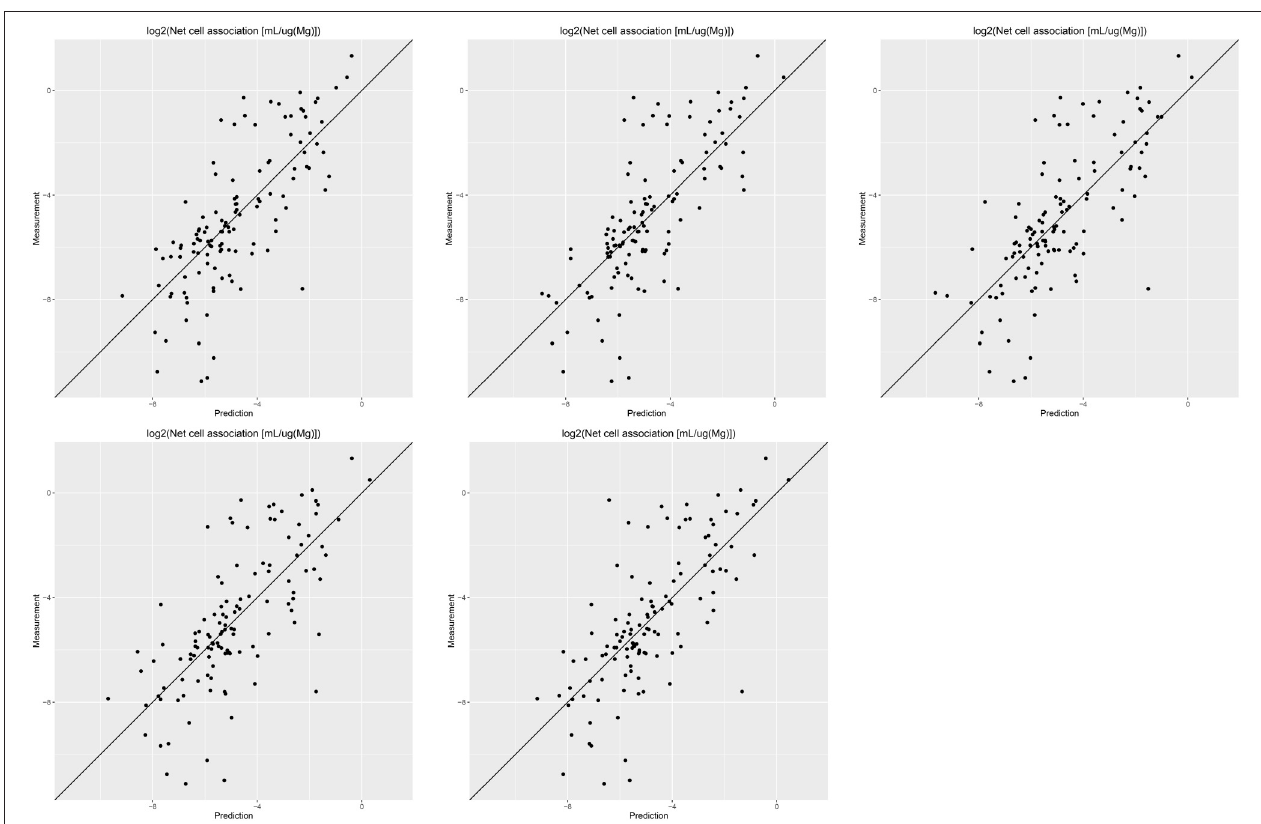
FIGURE 2 | Correlation of predicted vs. measured values for five independent crossvalidations with P-CHEM descriptors and local random forest